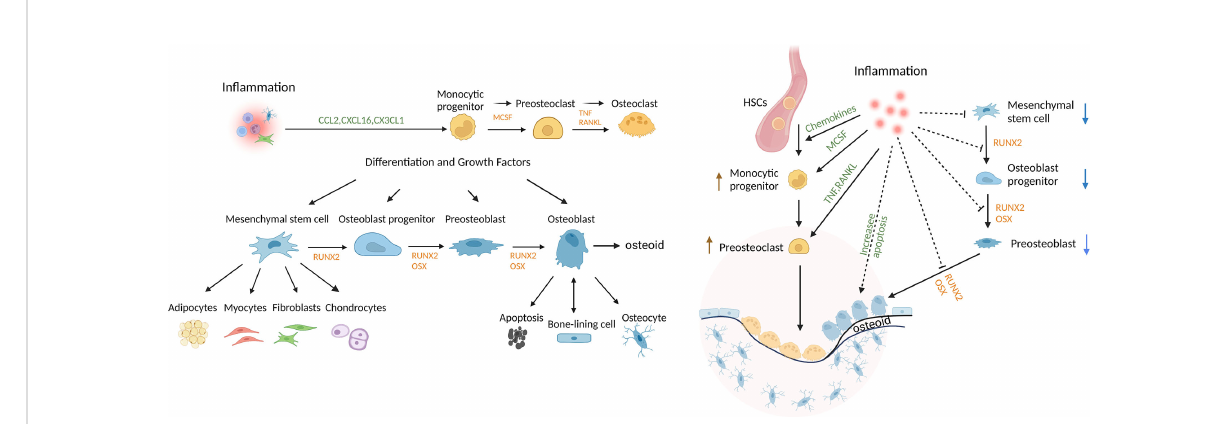
FIGURE 1 Regulation of bone and the impact of in fl ammation. Mesenchymal stem cells (MSCs) can differentiate into multiple lineages and are regulated by growth and differentiation factors that induce transcriptional programs that are lineage-speci fi c. Osteoclasts are of myeloid lineage. In fl ammation promotes osteoclastogenesis, in part, by inducing osteocytes to produce chemokines, in fl ammatory cytokines and RANKL. In fl ammation also reduces coupled bone formation by inducing osteoblasts/osteocytes to produce inhibitors of Wnt signaling, DKK2 and sclerostin, interfering with differentiation at several steps, limiting the production of bone matrix, osteoid, and inducing apoptosis of mesenchymal stem cells, OB progenitors, OB and osteocytes. Thus, bone lining cells, OB and osteocytes play an important role in maintaining periodontal bone mass through secreting factors that regulate the balance of osteoclastogenesis and